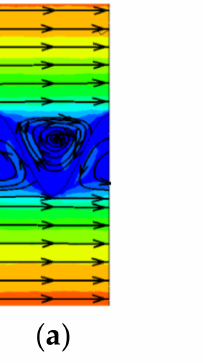
Figure 8. Velocity distributions and streamlines on the middle cross section of the hole at Re = 27,900. ( a ) BP case; ( b ) one-circle case; ( c ) one rectangle